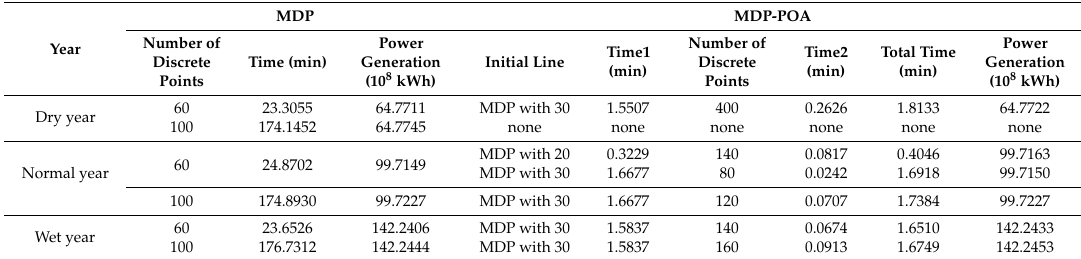
Table 6. Extracted data of MDP and MDP-POA from Tables